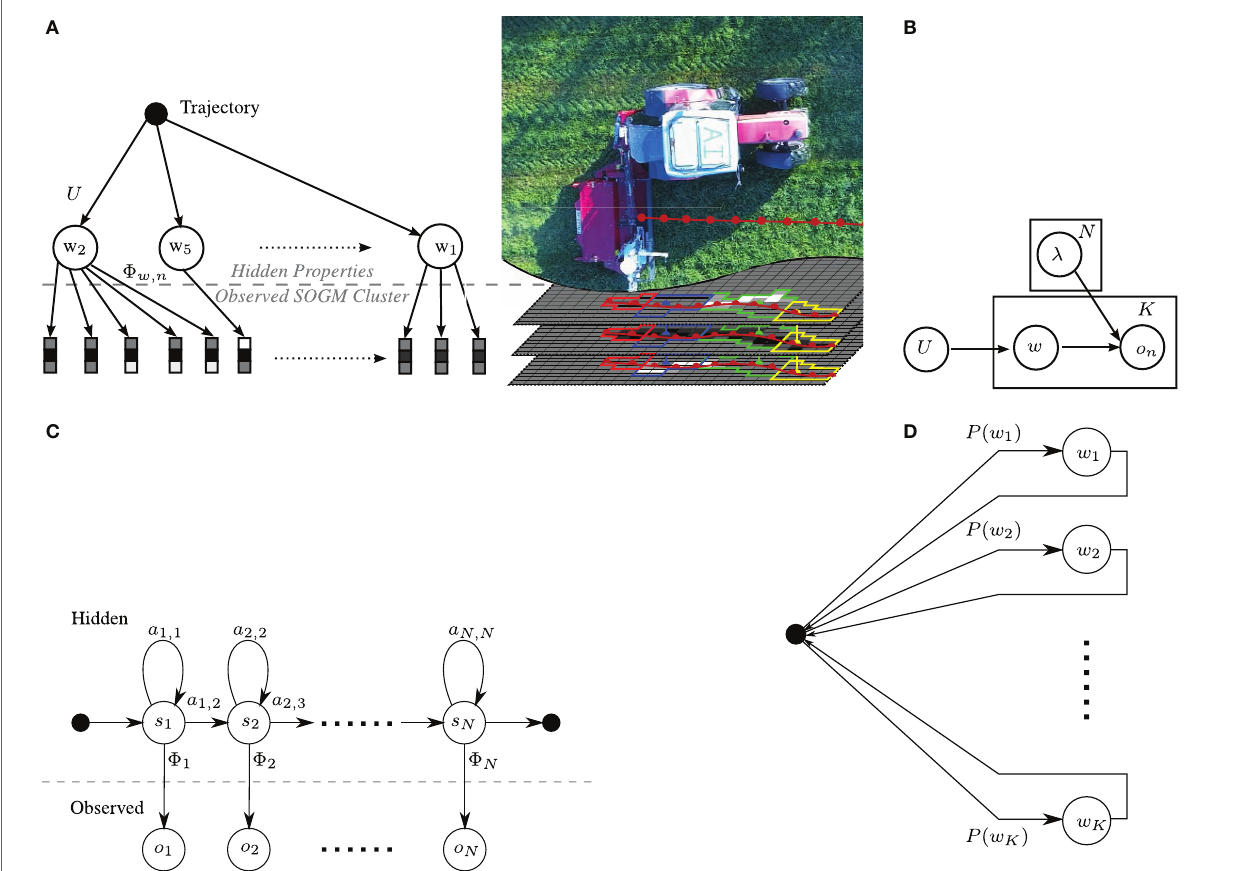
FIGURE 7 | Generative model and Hidden Markov model framework for identifying properties in the mapped data. (A) Conceptual representation of the proposed framework with the generative sampling on the left and a corresponding scenario with observations along the red tractor trajectory on the right. (B) Generative model for property identification. Only o n is observed. (C) Left–right structure of one intra-property model (cid:21) w for the inter-property model (exit transition per state is not visualized). (D) Ergodic inter-property model of the